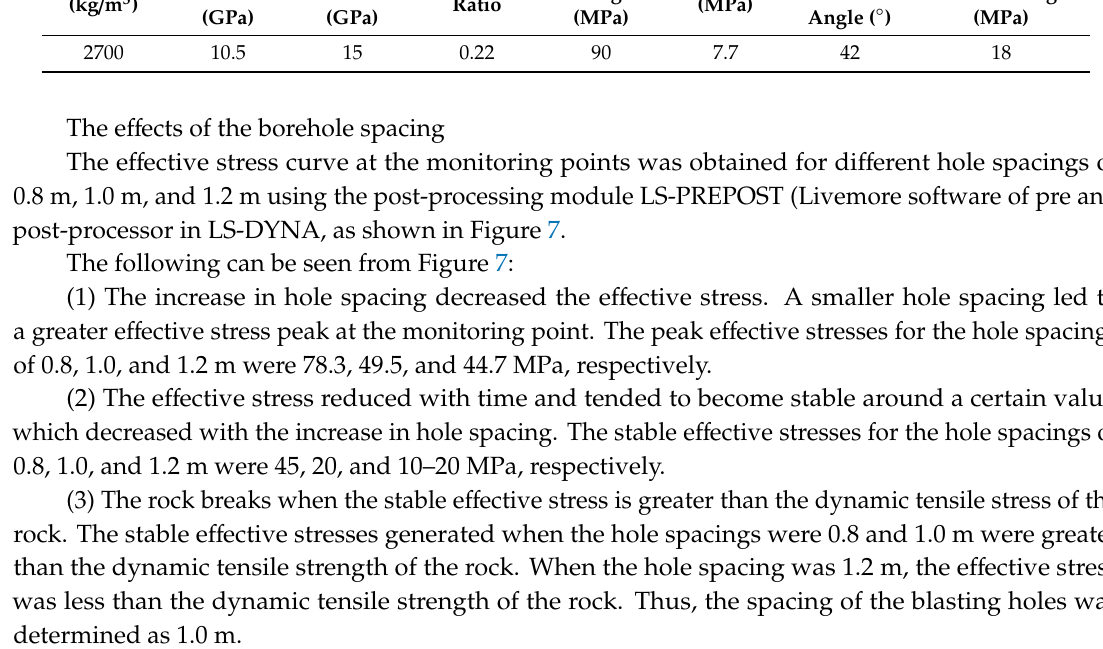
Table 4. Physico-mechanical parameters of rock in the numerical